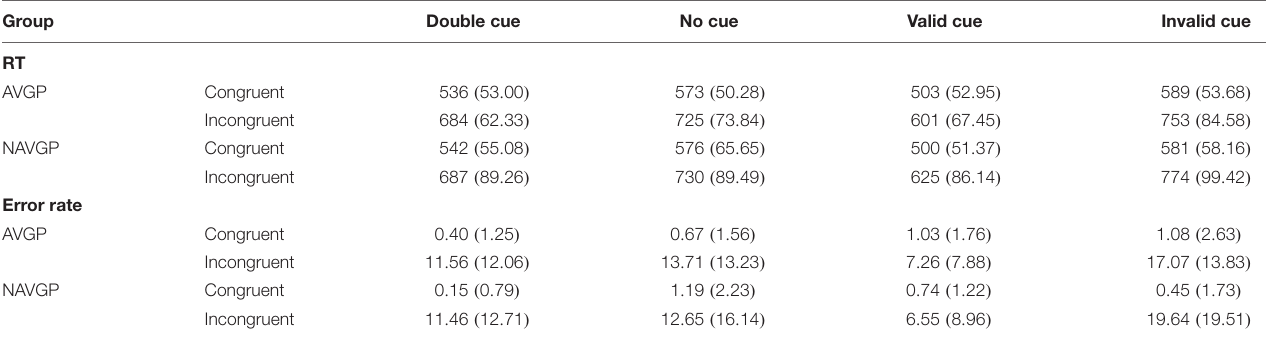
TABLE 2 | Mean (SD) reaction time (RTs, ms) and error rate (ER, %) for each condition in the